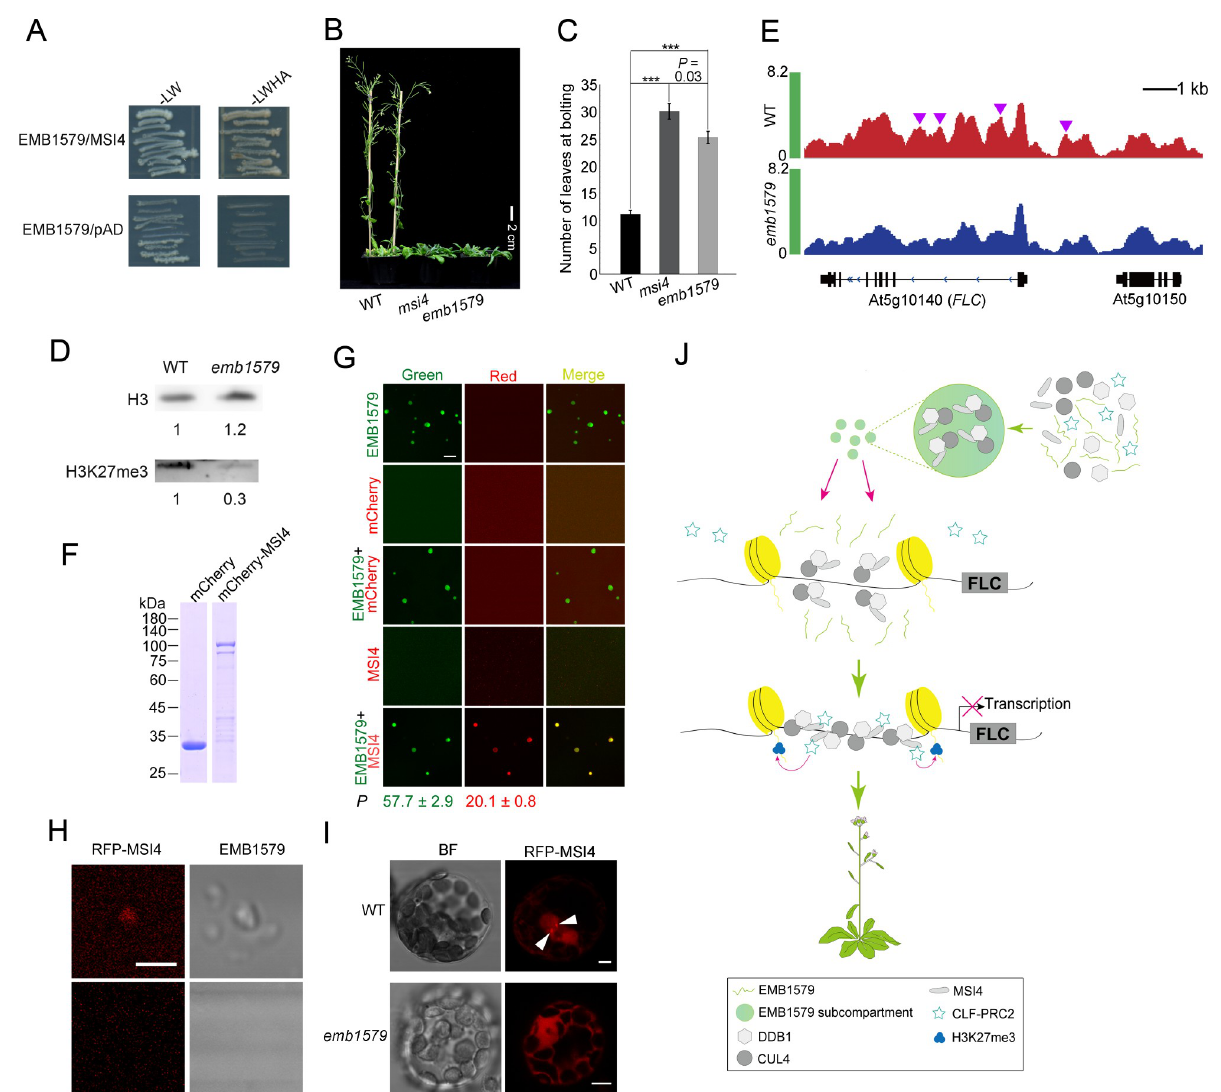
Fig 6. Phenotypic similarities between emb1579 and msi4 , and EMB1579 condensates can condense MSI4 in vitro and in vivo. ( A ) Yeast two- hybrid analysis of the interaction of MSI4 with EMB1579. ( B ) Images of 7-week-old Arabidopsis plants. WT, msi4 mutants, and emb1579 mutants are shown. Bar = 2 cm. ( C ) Quantification of the number of rosette leaves at bolting in WT, msi4 , and emb1579 . Data are presented as mean ± s.e.m. ��� P < 0.001 by Student t test. Numerical data underlying this panel are available in S1 Data. ( D ) Analysis of the global level of H3K27me3 in WT and emb1579 seedlings. The western blot of total nuclear proteins was probed with anti-H3 (top panel) and anti-H3K27me3 (bottom panel) antibodies. The original pictures are available in S1 Raw Images. ( E ) Representative genome browser view of H3K27me3 for the FLC locus in WT and emb1579 mutants. The H3K27me3 ChIP-seq peaks at the FLC locus in WT (red) and emb1579 (blue) and the gene structures examined by ChIP are shown in the top, middle, and bottom rows, respectively. The purple triangles indicate specific H3K27me3 peaks in WT. The underlying numerical data are available in S1 Data. ( F ) SDS-PAGE analysis of recombinant mCherry and mCherry-MSI4. The original pictures are available in S1 Raw Images. ( G ) Visualization of MSI4 and EMB1579 in vitro under conditions that cause phase separation of EMB1579 (F-buffer: 25 mM Hepes [pH 8.0], 100 mM KCl, 100 mg/ml PEG 3350). mCherry, 12 μ M; mCherry-MSI4, 20 nM; EMB1579, 2.5 μ M. The partition coefficient values ( P ) were measured from 120 EMB1579 condensates and 120 MSI4 condensates. Data are presented as mean ± s.e.m. Bar = 10 μ m. The underlying numerical data are available in S1 Data. ( H ) Condensation of RFP-MSI4 from Arabidopsis root total extract. EMB1579 was incubated with total protein extracted from roots of Arabidopsis expressing 35S :: RFP-MSI4 . The incubation was carried out in P buffer (25 mM Tris-HCl [pH 8.0], 100 mM KCl, 2 mM DTT, 100 mg/ml PEG 3350). The lower panel shows the total protein extract without EMB1579. Bar = 2 μ m. ( I ) Micrographs of Arabidopsis protoplasts derived from WT or emb1579 expressing RFP-MSI4. White triangles indicate MSI4 compartments. Bars = 5 μ m. ( J ) A simple model describing the function of EMB1579 in regulating the transcription of FLC and flowering. EMB1579 condenses the CUL4-DDB1 MSI4 complex to facilitate its interaction with CLF-PRC2 complex. This increases the level of H3K27me3 on the FLC locus and represses the expression of FLC to promote flowering. ChIP-seq, chromatin immunoprecipitation sequencing; CLF-PRC2, CURLY LEAF containing Polycomb Repressive Complex 2; CUL4, Cullin 4; DDB1, DNA Damage Binding Protein 1; EMB1579, EMBRYO DEFECTIVE 1579; FLC , FLOWERING LOCUS C ; H3K27me3, trimethylation of lysine 27 of histone H3; MSI4, MULTIPLE SUPPRESSOR OF IRA 4; RFP, red fluorescent protein; WT, wild type.